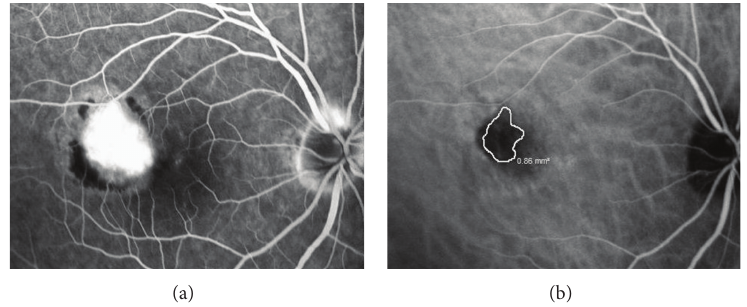
Figure 1: The baseline fluorescein angiography (a) and indocyanine green angiography (b) images of a 37-year-old subject with subfoveal idiopathic choroidal neovascularization. The choroidal neovascularization is encircled in white with the corresponding surface area calculation on the indocyanine green angiography image. The Snellen visual acuity was 20/80.